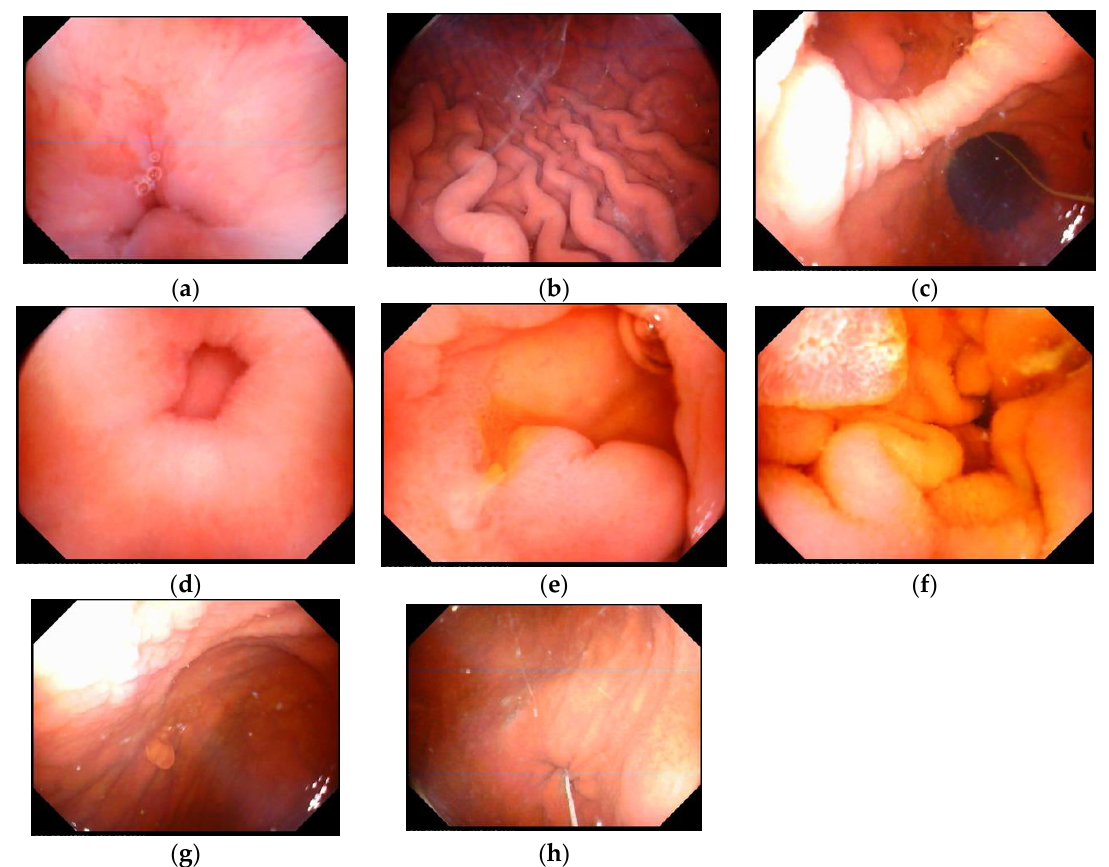
Figure 2. Landmark images of the upper gastrointestinal tracts by magnetic-assisted capsule endoscopy. ( a ) Esophago- gastric junction, ( b ) gastric body, ( c ) antrum and angularis, ( d ) pylorus, ( e ) duodenal bulb, ( f ) duodenal second portion, ( g ) fundus, ( h ) cardia.